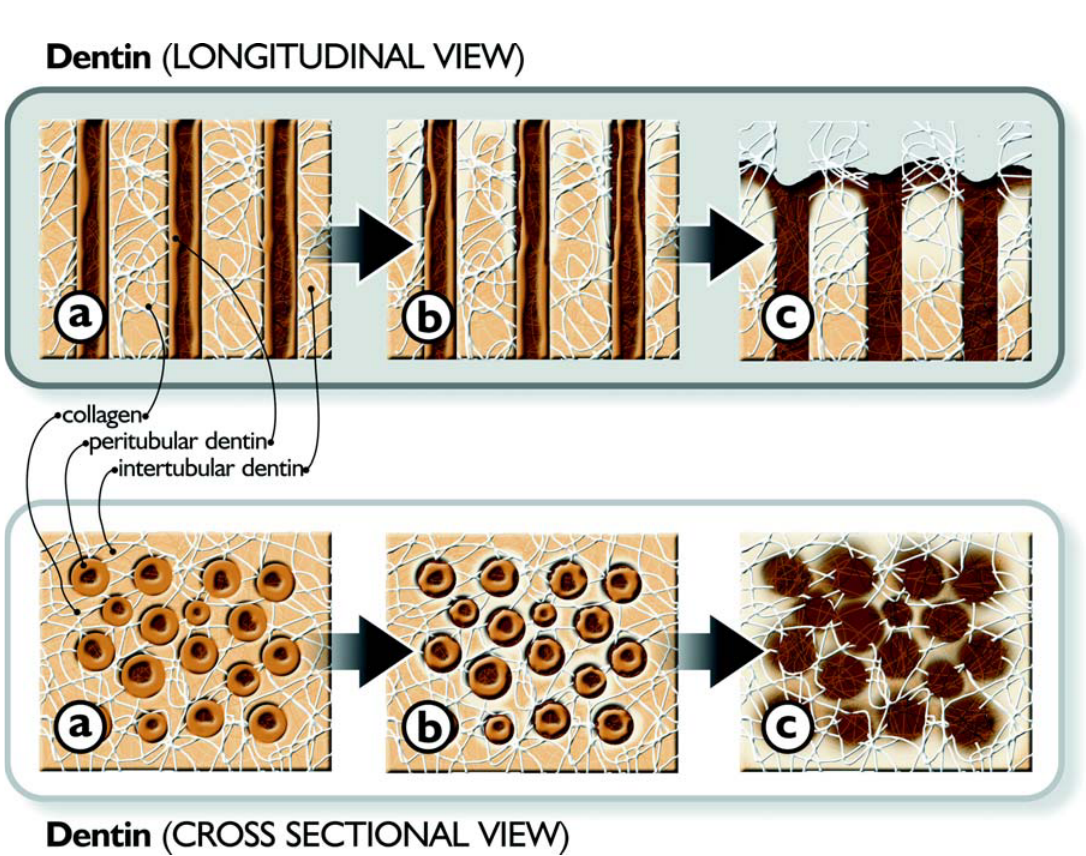
FIGURE 7- Erosive demineralization of dentin (longitudinal and cross-sectional view). a-c. Progression of the erosion process in dentin (a. sound dentin, b. initial demineralization, c. exposure of organic